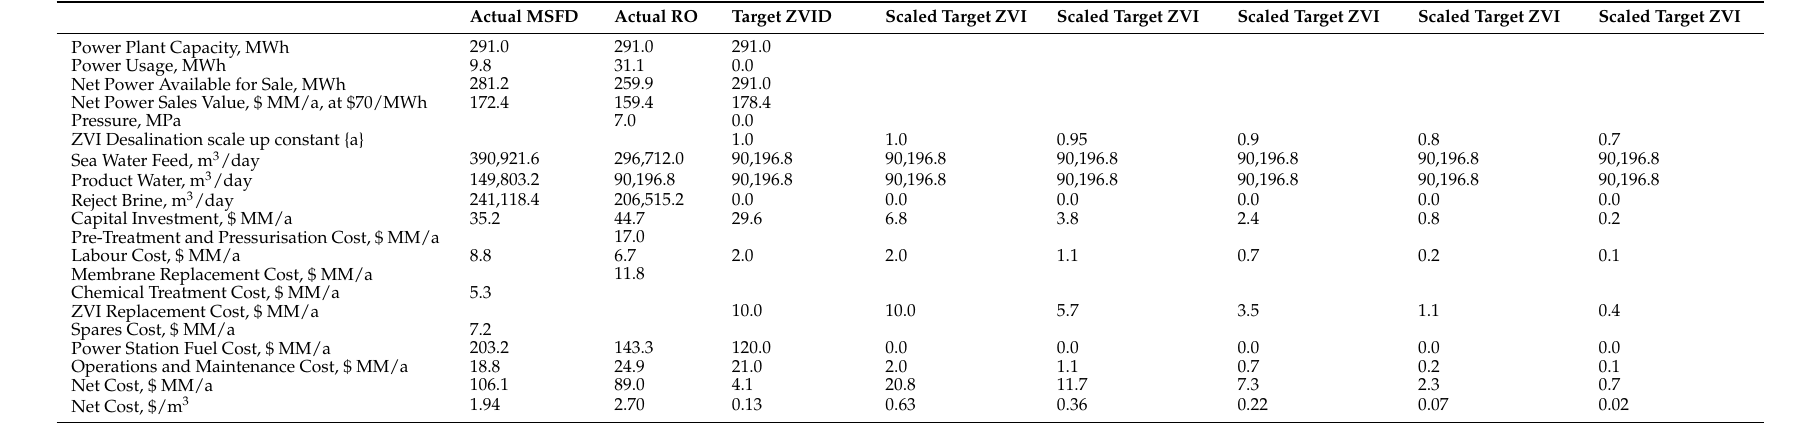
Table 3. Comparison of integrated power station-desalination unit complexes. MSFD = Multi-stage flash distillation + power station; RO = Reverse Osmosis + power station; ZVID = ZVI desalination + power station; ZVI = ZVI desalination without the power station; Assumed Target Capital Investment for the schematic ZVI desalination Aquifer Treatment Zone is $300 MM, (calculated using Equation (15)), when {a} = 1.0. MM = million; $ = US dollars. MSFD, RO, and Power Station Costs and Structures are from Reference [87]. Power Station characteristics [87]: 24.2 MPa Steam Pressure; 6 KPa Condenser Pressure; 25.2 MJ · kg − 1 Coal HLV; 92%